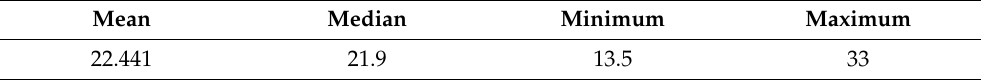
Table 3. Descriptive statistics for the variable “harvest” (28 observations in 1994–2021).